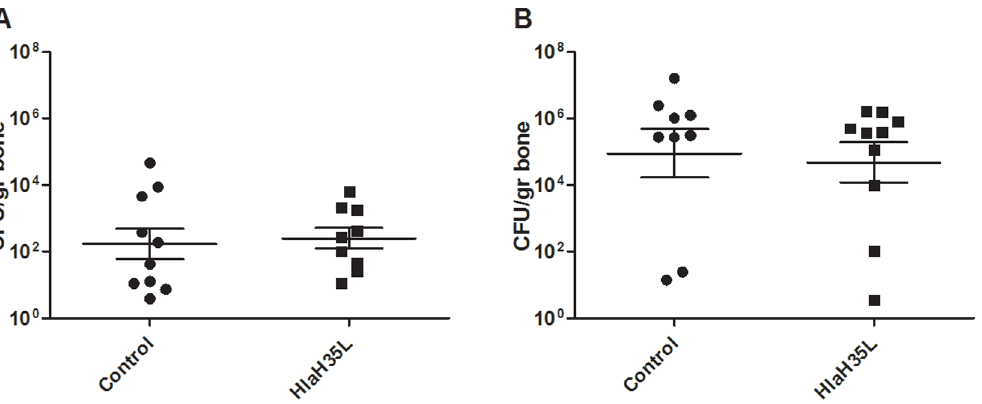
N Figure 4. Analysis of HlaH35L in a prosthetic implant model of S.aureus infection. Control animals receiving aluminum hydroxide with CpG ) and animals receiving HlaH35L with adjuvant ( & ) were compared. Shown are the results for two experiments performed identically (A adjuvant ( and B). The CFU per gram of bone are plotted, with the mean + / 2 SEM indicated for each group.